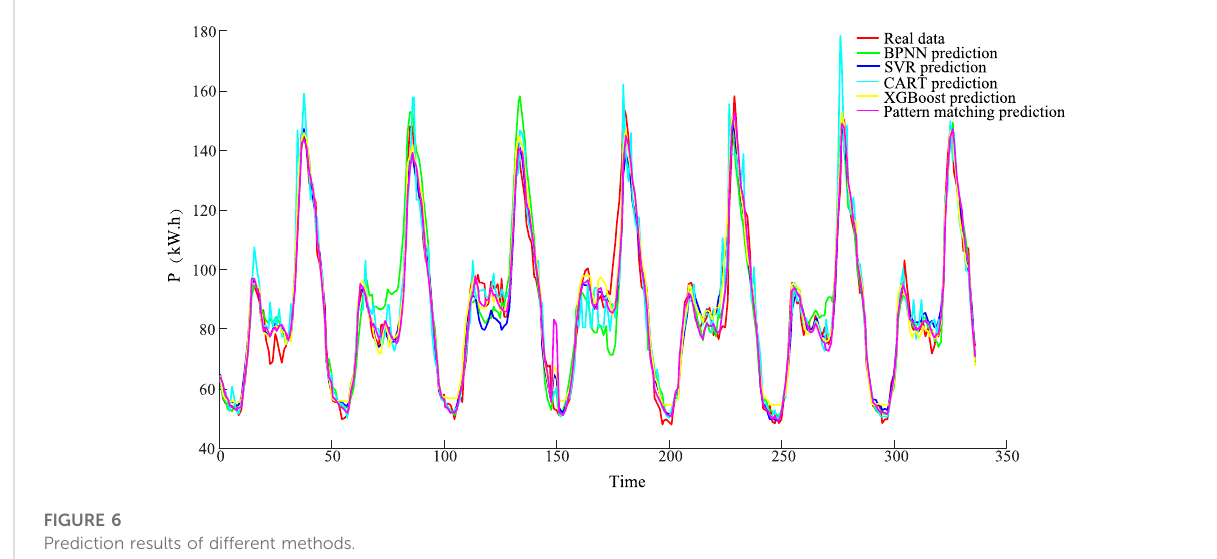
FIGURE 6 Prediction results of different